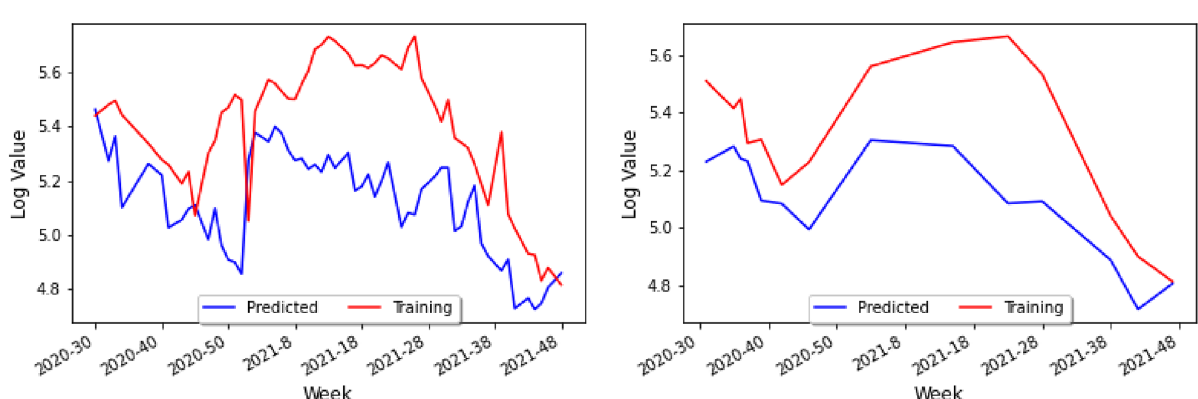
Figure 14. Actual data and the predicted data for Brazil when both holiday and climate factors are considered on the training set (left) and the test set